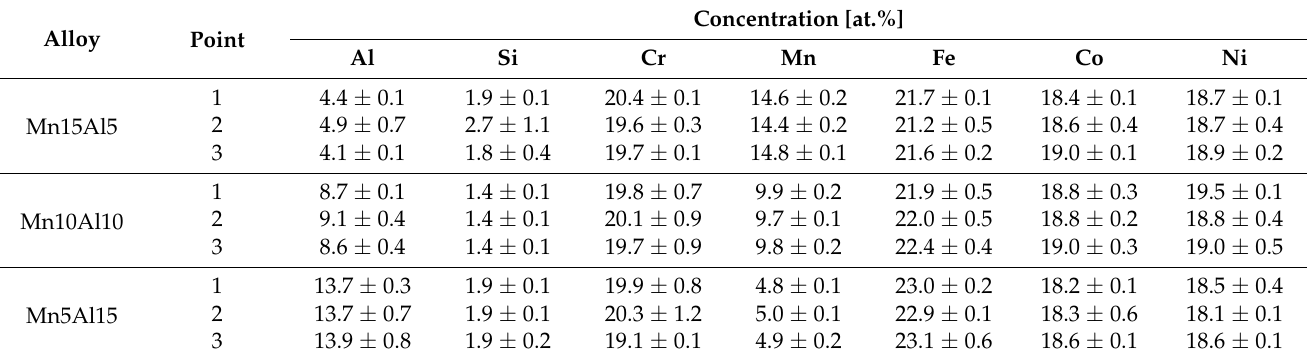
Table 3. SEM + EDS analysis of the chemical composition of points marked in Figure 4. Concentration [at.%] Alloy Point